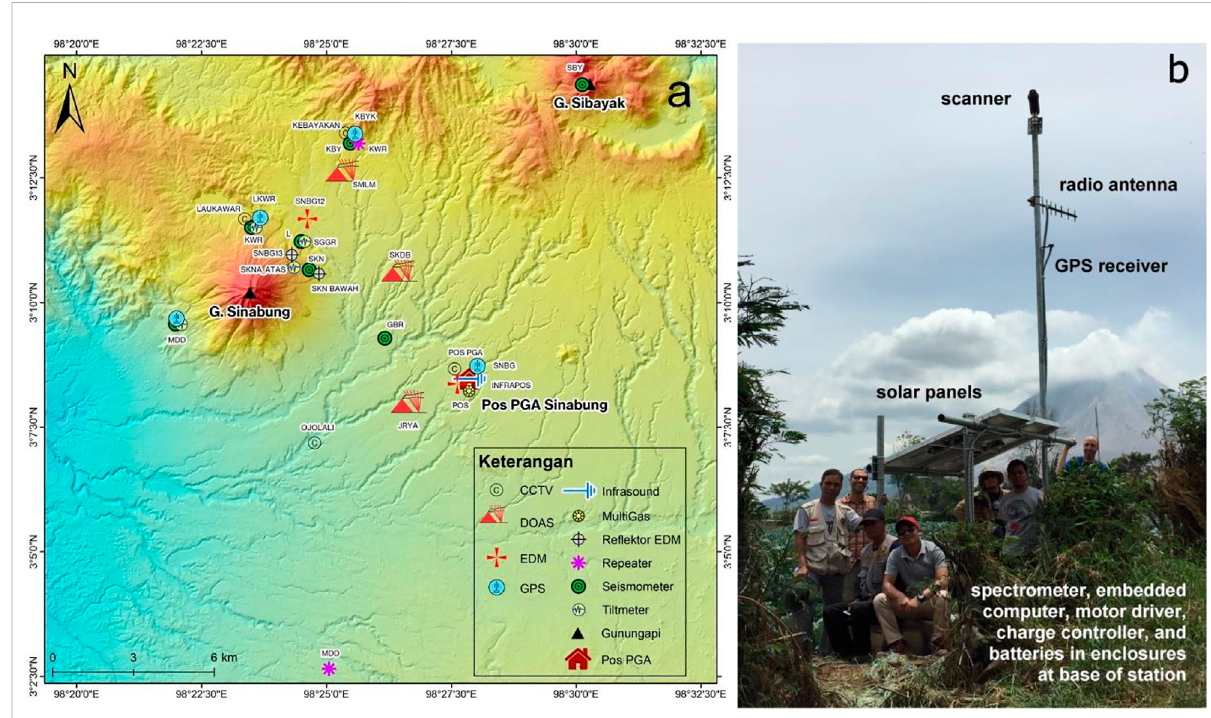
FIGURE 1 (A) Volcano monitoring network maintained by CVGHM at Sinabung. The red symbols labeled SMLM (site ‘ Simalem ’ ), SKDB (site ‘ Sukandebi ’ ), and JRYA (site ‘ Jeraya ’ ) indicate the locations of the NOVAC scanning DOAS instruments installed in 2016. Data from these instruments are telemetered to the radio repeater KWR and then on to the pos (observatory; house symbol) in real time. Explosion column height observations are also made from the pos. (B) Photograph of the DOAS station installed at JRYA in 2016. Photo by Syegi Kunrat,